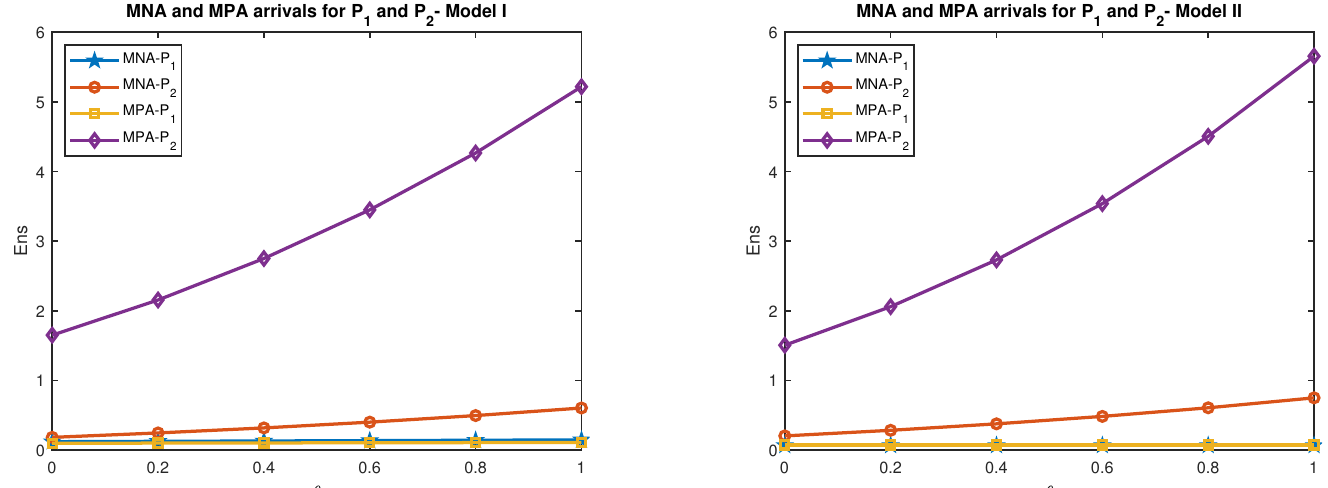
Figure 2. Effect of θ on expected number of P 1 and P 2 customers in the system for MNA and MPA arrival processes with correlation of − 0.4211 and 0.4211, respectively (when L =